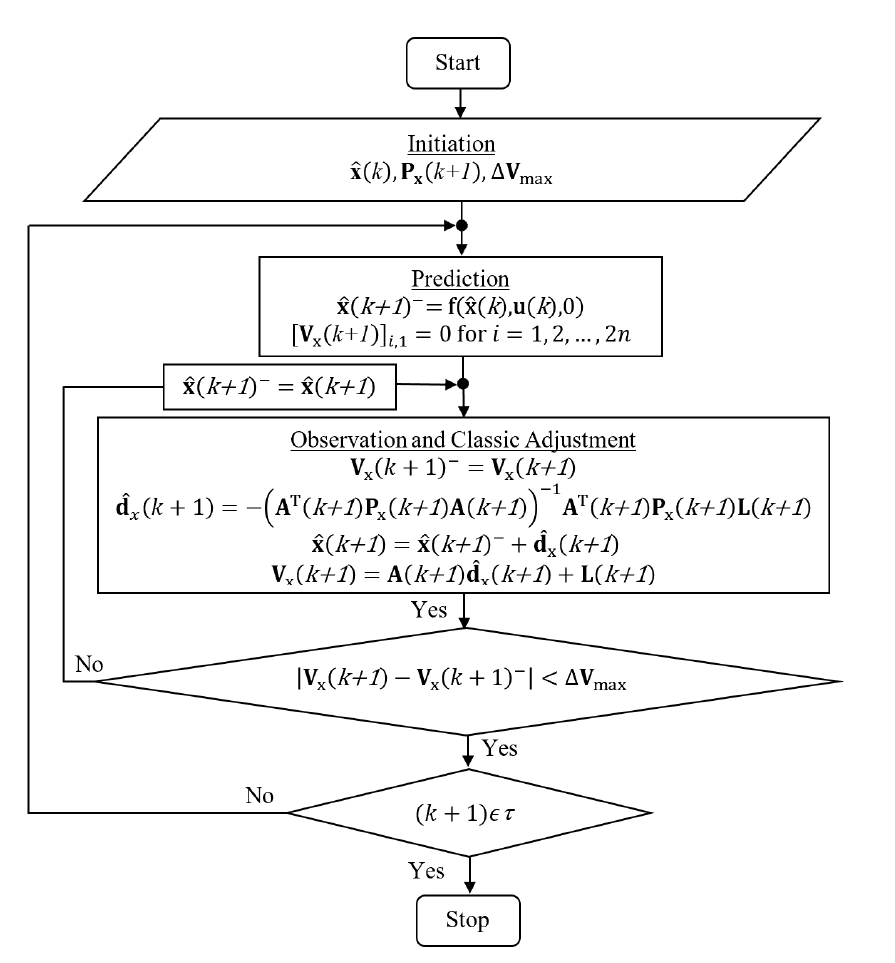
Figure 2. Algorithm for state vector estimation (cid:98) x ( k + 1 ) using classical geodetic